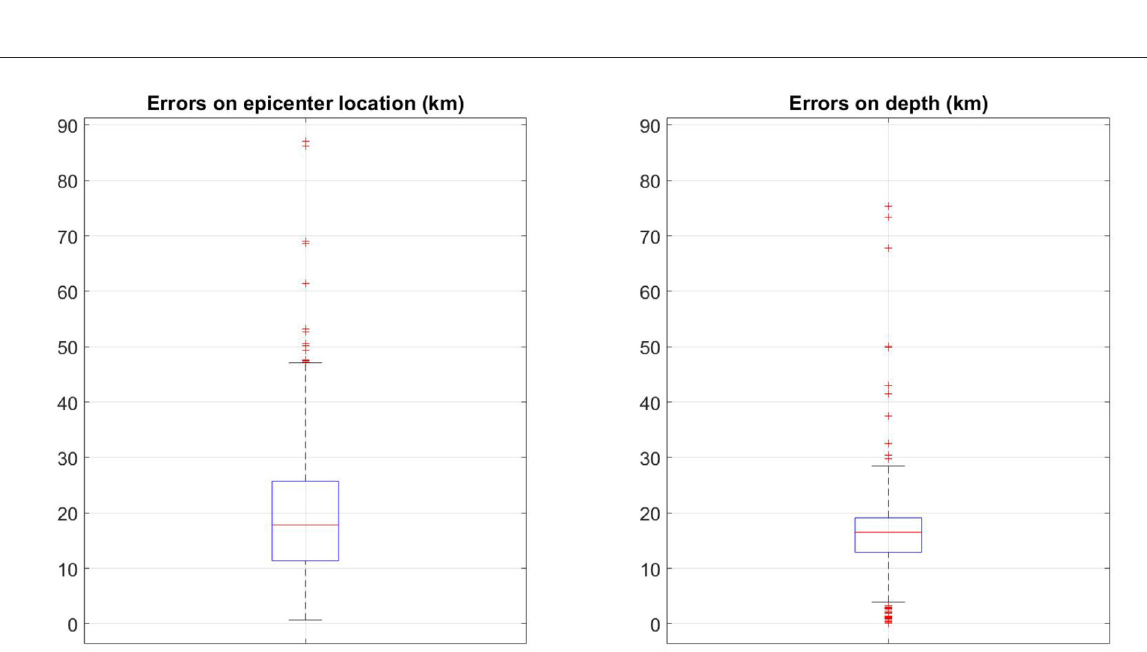
generated in the range [0, 12] s. This implies that when the earthquake is detected by the EQN detection algorithm, the list of triggering smartphones may include triggers unrelated to the earthquake